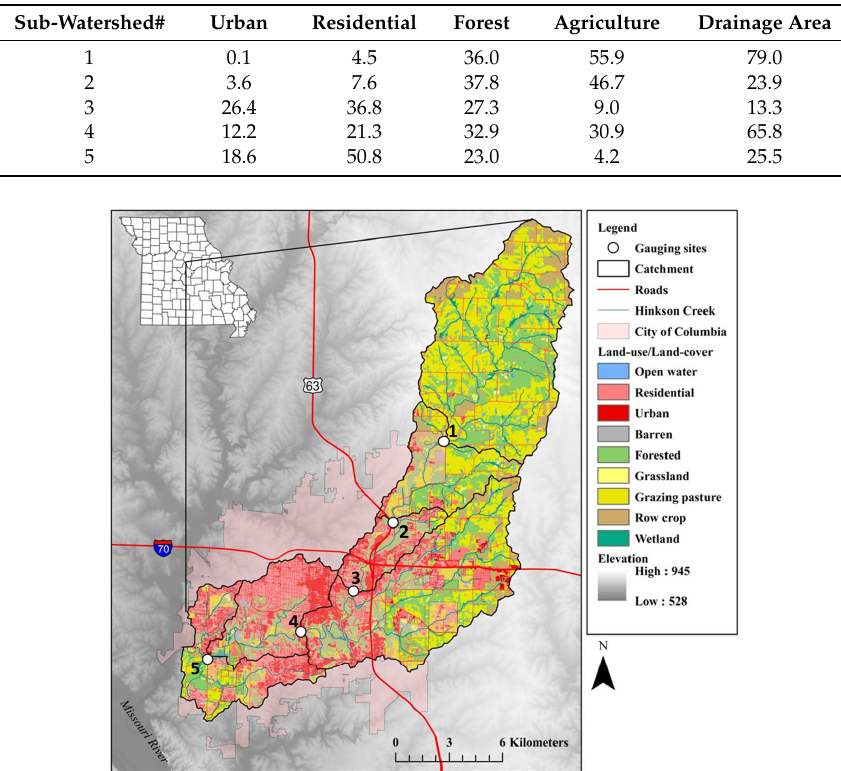
Table 1. Sub-watershed land use/land cover (%) and drainage area (km 2 ) for each sub-watershed located in Hinkson Creek Watershed (HCW), MO, USA.